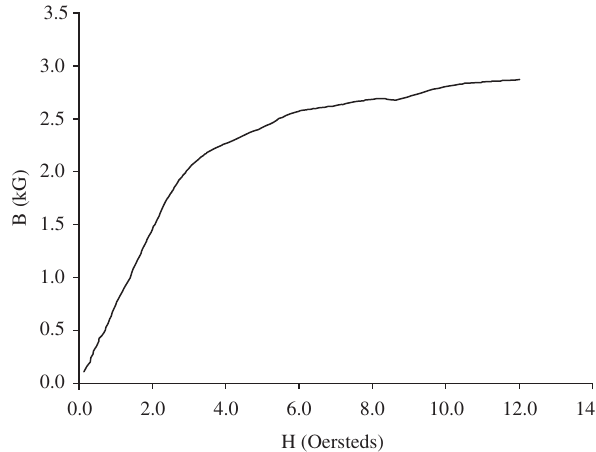
Figure 5. Representative curve of the variation of field applied versus induced field, of alloy Co